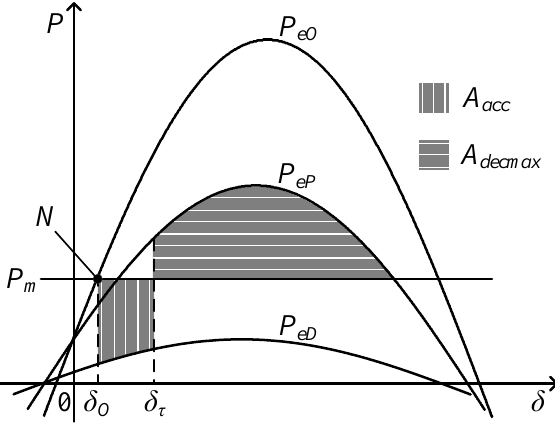
Figure 4. P -δ curves of the equivalent one-machine infinite-bus (OMIB) system. Figure 4. P - δ curves of the equivalent one-machine infinite-bus (OMIB)